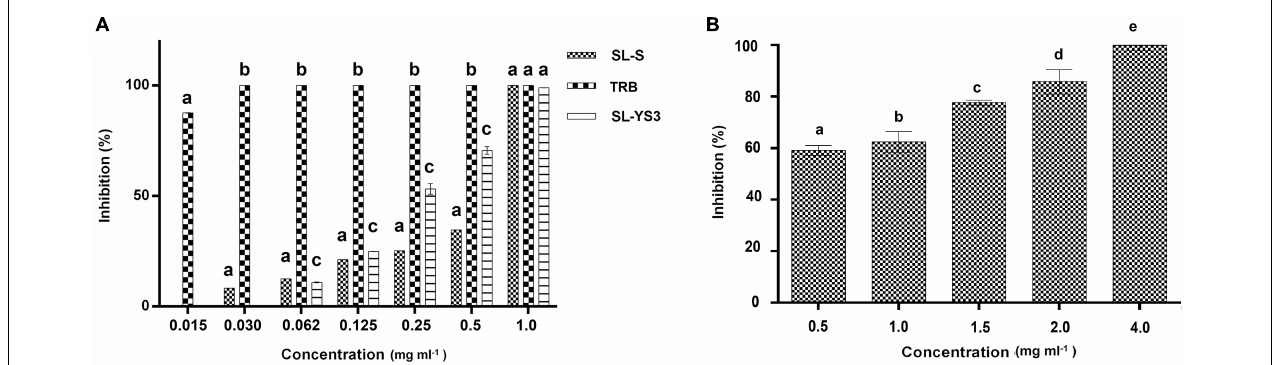
FIGURE 4 | Antifungal activity of sophorolipid produced by R. babjevae YS3 (SL-YS3) against Trichophyton mentagrophytes in vitro . (A) Dose-dependent effect of purified SL-YS3, sophorolipid standard 1, 4 (cid:48)(cid:48) -sophorolactone 6 (cid:48) ,6 (cid:48)(cid:48) -diacetate (SL-S), terbinafine (TRB) against spores of T. mentgrophytes as determined according